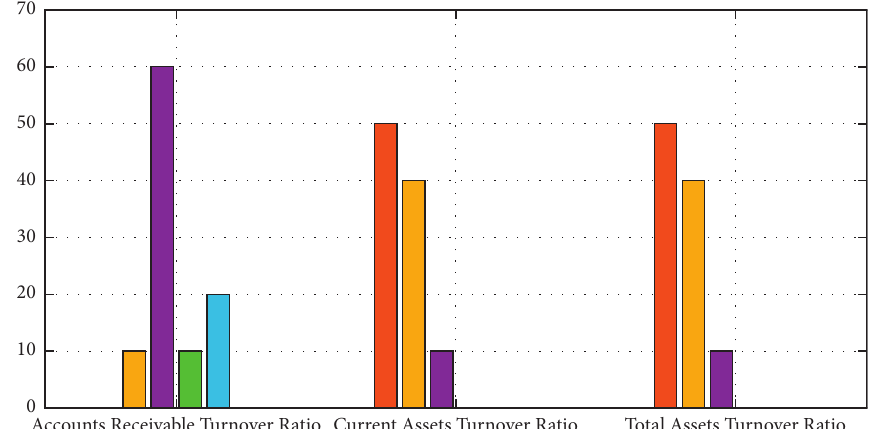
Figure 6: Histogram of the results of the scoring of the capital operation risk